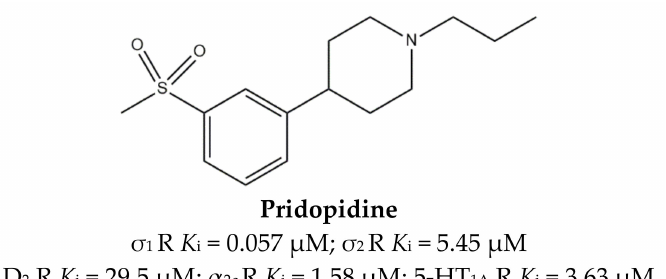
Figure 10. Pridopidine structure and its K i values for σ ( σ 1 R and σ 2 R), dopaminergic D 2 (D 2 R), alpha-2c adrenergic ( α 2c R) and serotoninergic 5-HT 1a (5-HT 1a R) receptors [75].